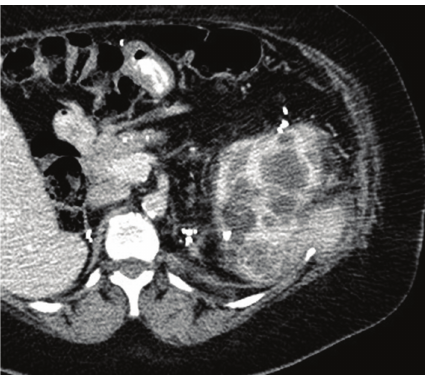
Figure 1: Preprocedure enhanced CT shows a mixed solid and cystic enhancing posterior renal tumor (6 o’clock in